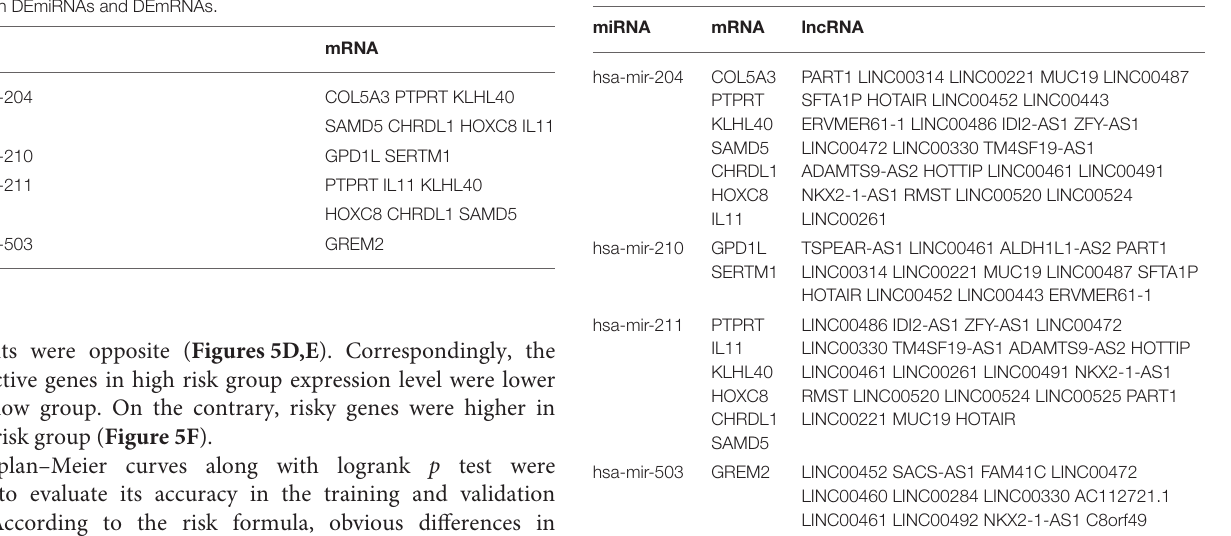
TABLE 6 | lncRNA-miRNA-mRNA